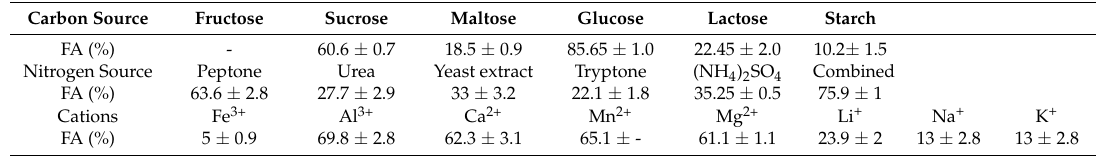
Table 1. Effect of Carbon, Nitrogen and Cation Sources on Bioflocculant Production by Bacillus sp.